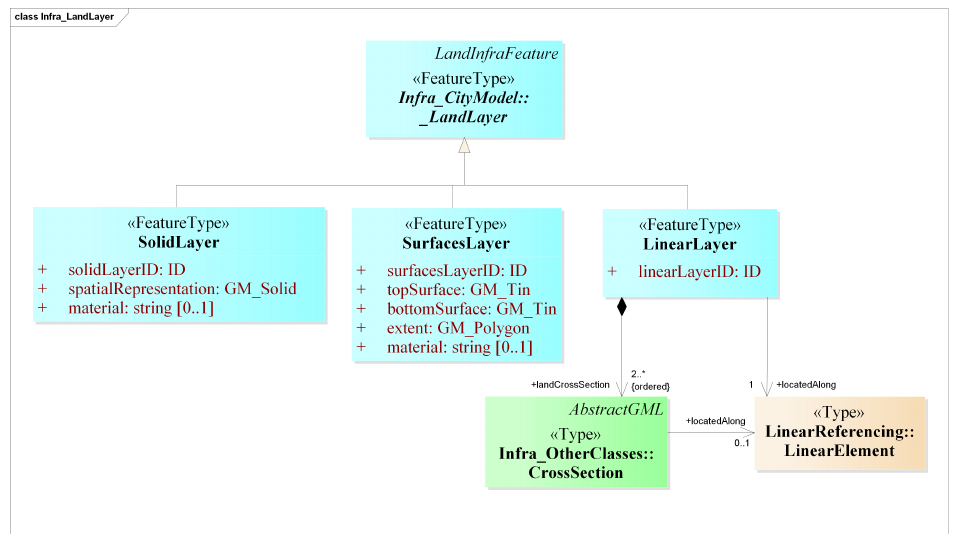
Figure 6. The UML excerpt depicts new LandInfra feature _LandLayer introduced in the CityGML Infra ADE to represent the layers underneath the land